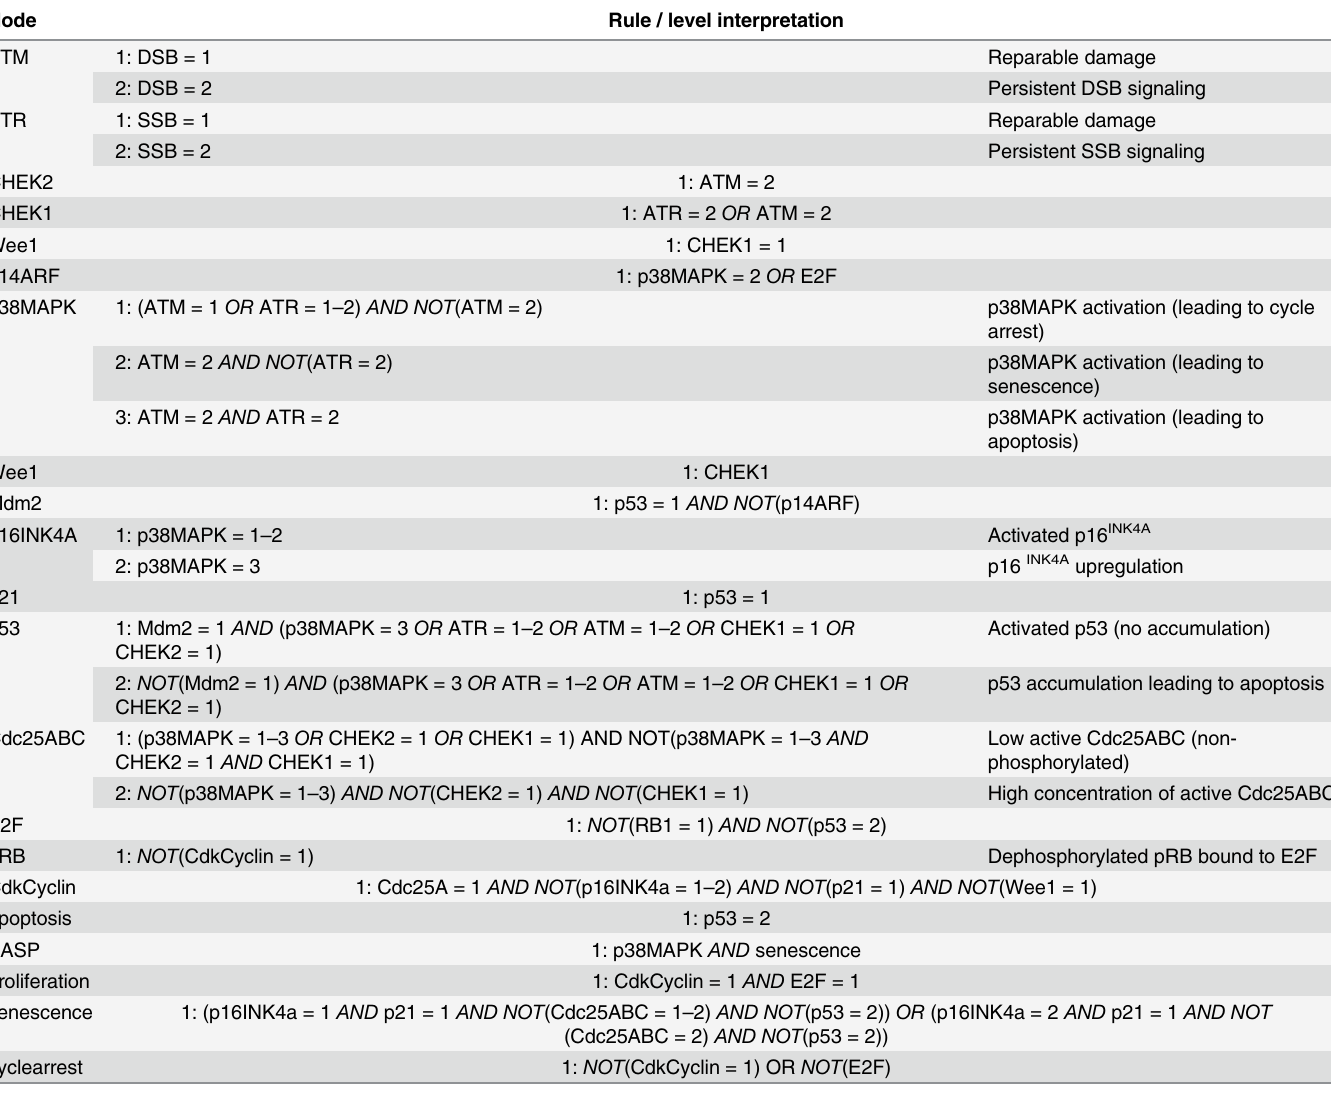
Table 2. Logical